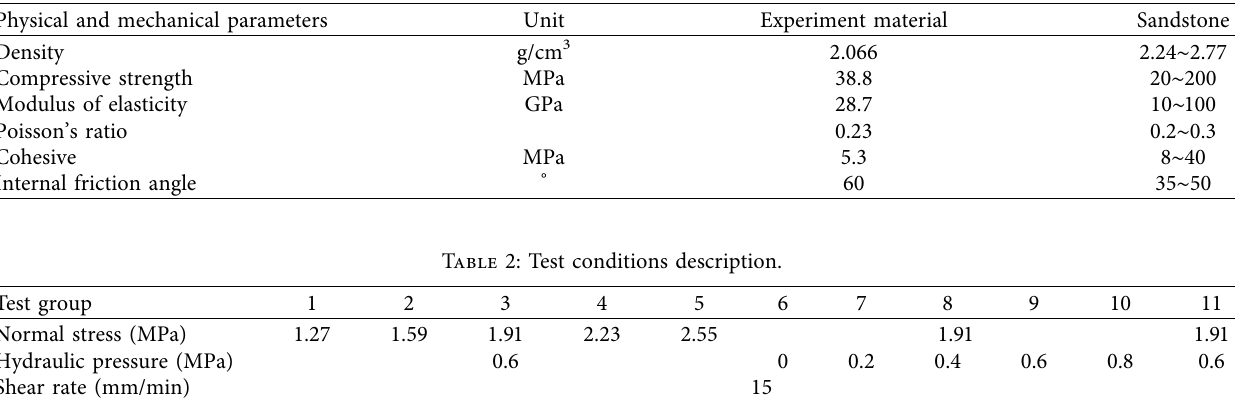
Figure 2: Schematic figure of shear box internal structure and specimen assembly. (a) Shear box internal structure. (b) Smooth specimen surface. (c) Rough specimen surface. Table 1: Mechanical property parameters of specimens.